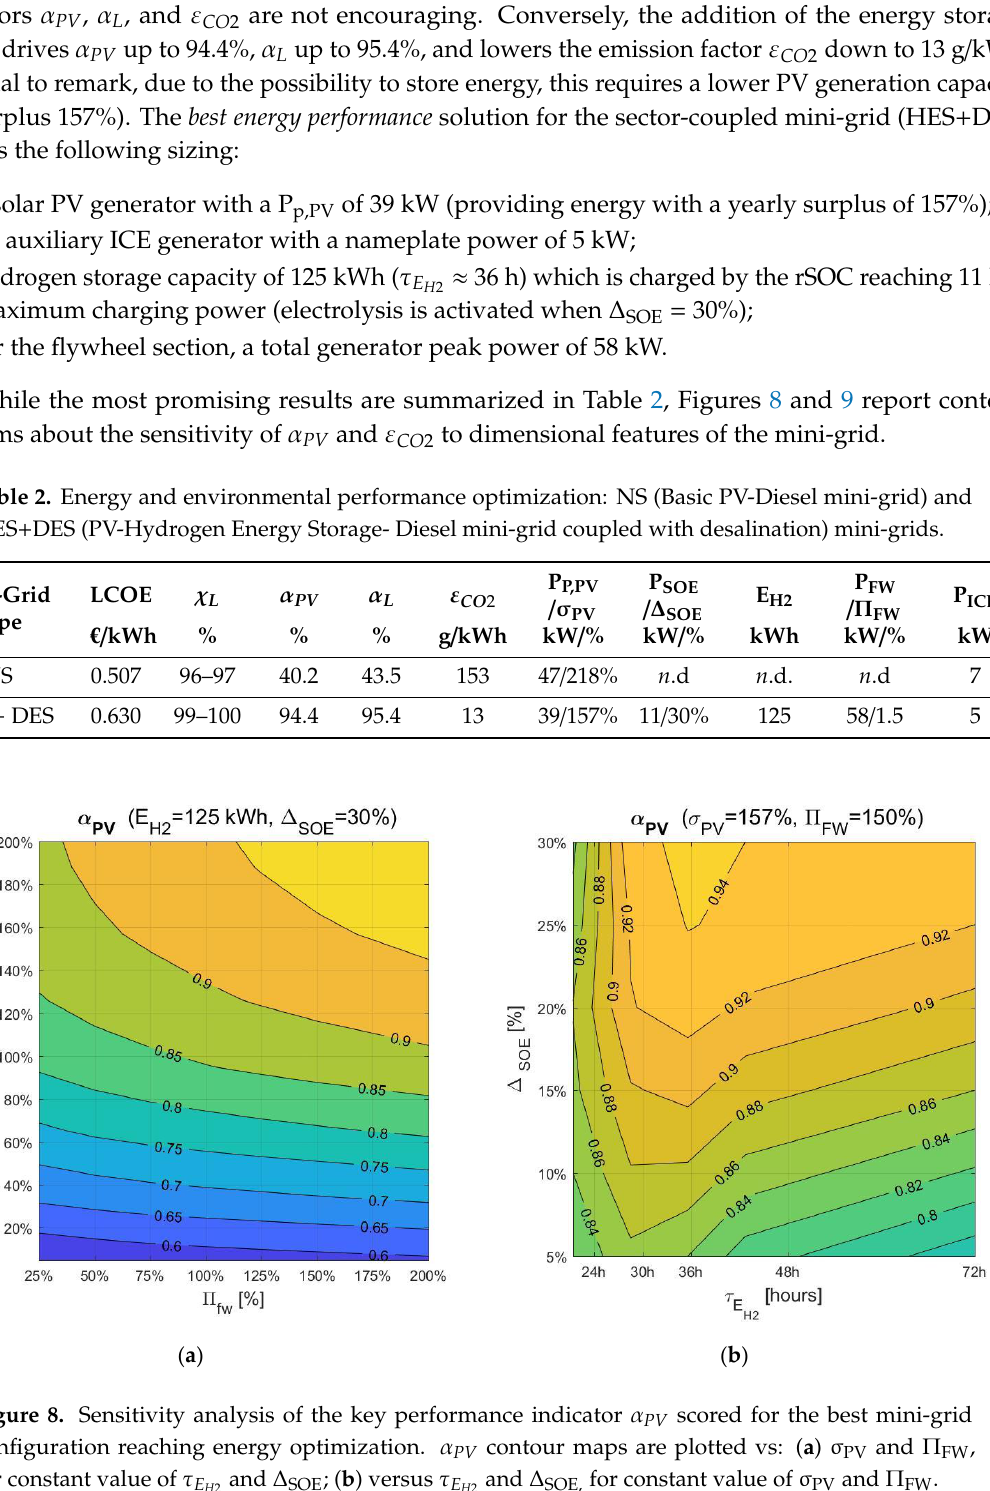
( b ) Figure 9. Sensitivity analysis of the key performance indicator 𝜀 𝐶𝑂2 scored in the best mini-grid configuration reaching environmental optimization. 𝜀 𝐶𝑂2 contour maps are plotted vs: ( a ) σ PV and Π FW , for constant value of 𝜏 𝐸 𝐻2 and Δ SOE ; ( b ) versus 𝜏 𝐸 𝐻2 and Δ SOE, for constant value of σ PV and Π FW.